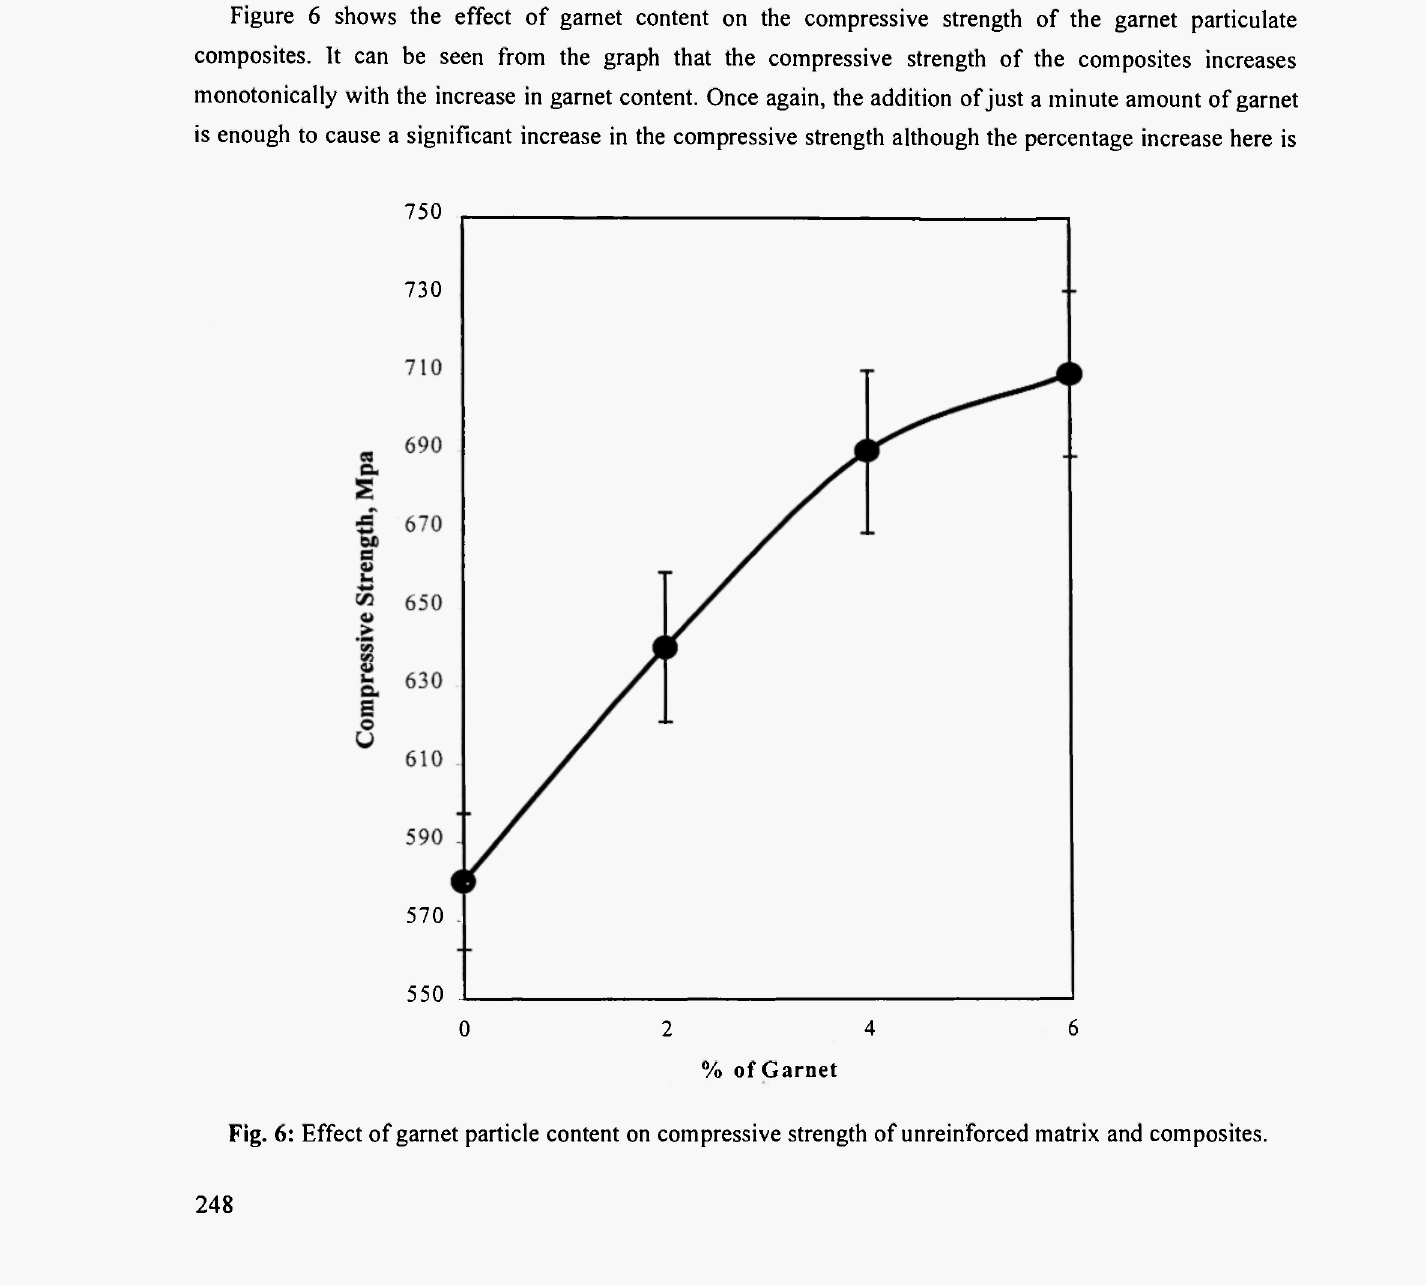
Fig. 6: Effect of garnet particle content on compressive strength of unreinforced matrix and composites.